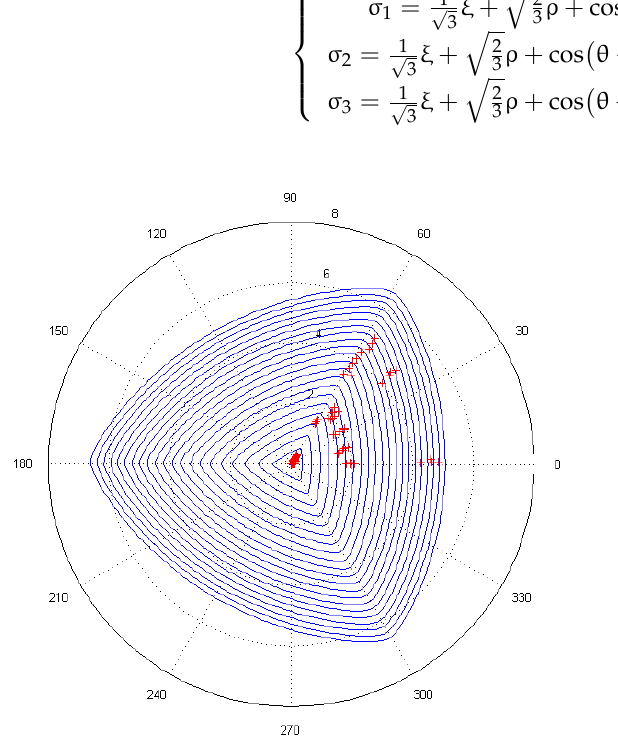
Figure 20. The experimental fitting on the yield surface curve in the deviatoric plane.